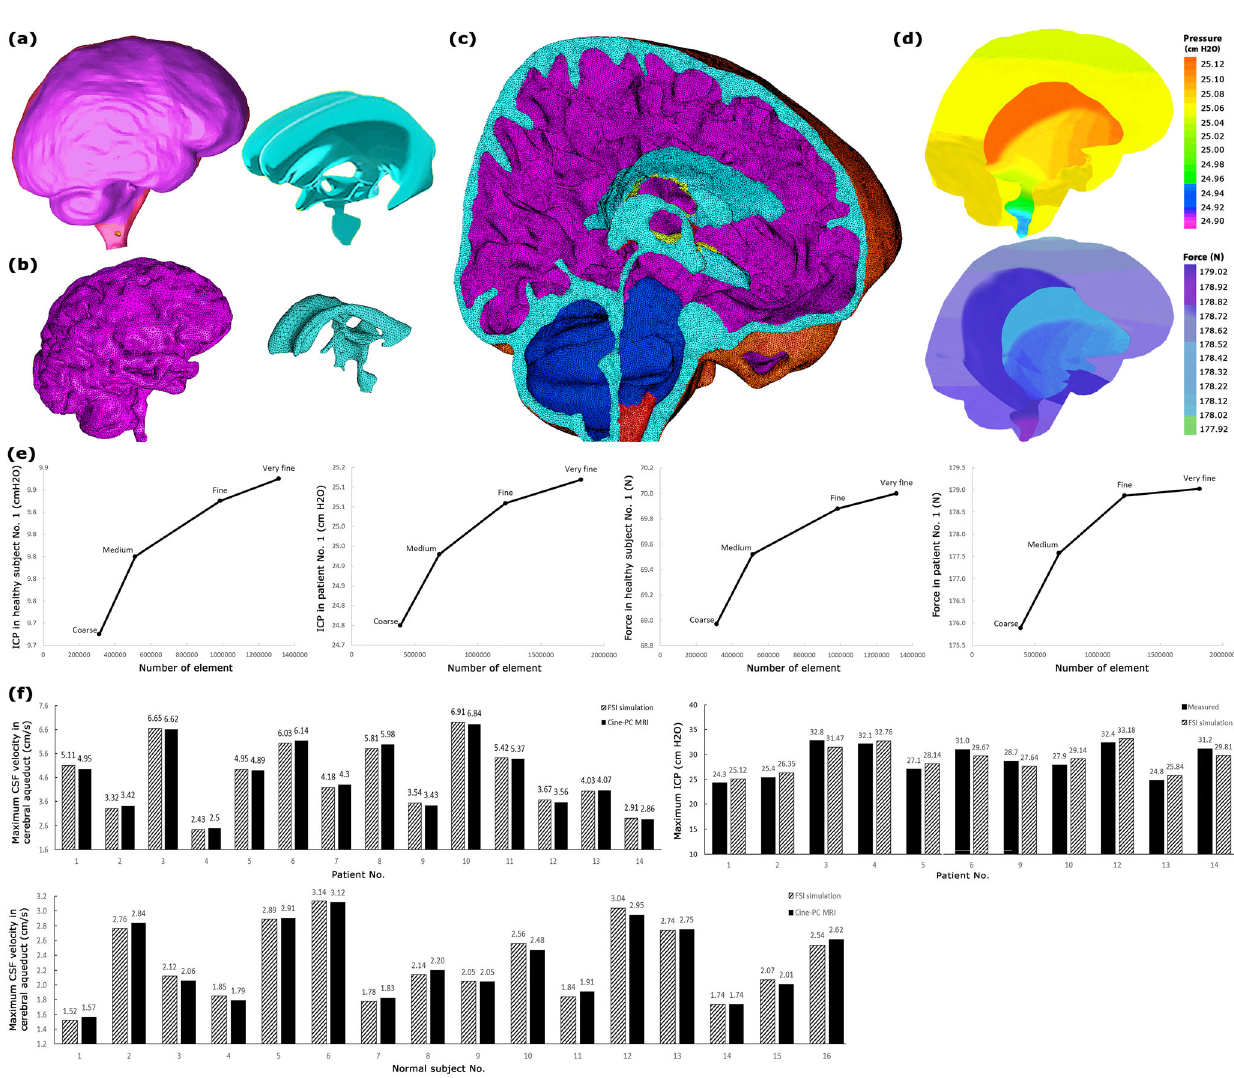
Fig. 1 Computer simulation and data validation. a 3-D models of the outer layer of subarachnoid space and ventricular system (not to scale) for patient No. 1 before shunting. b Meshed models of brain and ventricular system (not to scale) for patient No. 1 fi fteen months after shunting. c meshed model of the head substructure for patient No. 1 fi fteen months after shunting. Turquoise and purple areas represent the fl uid domain (CSF space: ventricular system and subarachnoid) and solid domain (brain), respectively. The borders and interfaces between turquoise and purple areas are the FSI boundaries. d The FSI simulation results for ICP and force for patient No. 1 before shunting. e Grid independence study. f Validation of the maximum CSF velocity in the cerebral aqueduct and maximum ICP which were measured using FSI simulation. Raw data for panel f is included in Supplementary Table 1. CSF cerebrospinal fl uid, ICP intracranial pressure, FSI fl uid-structure interaction, Cine-PC MRI cine phase-contrast magnetic resonance